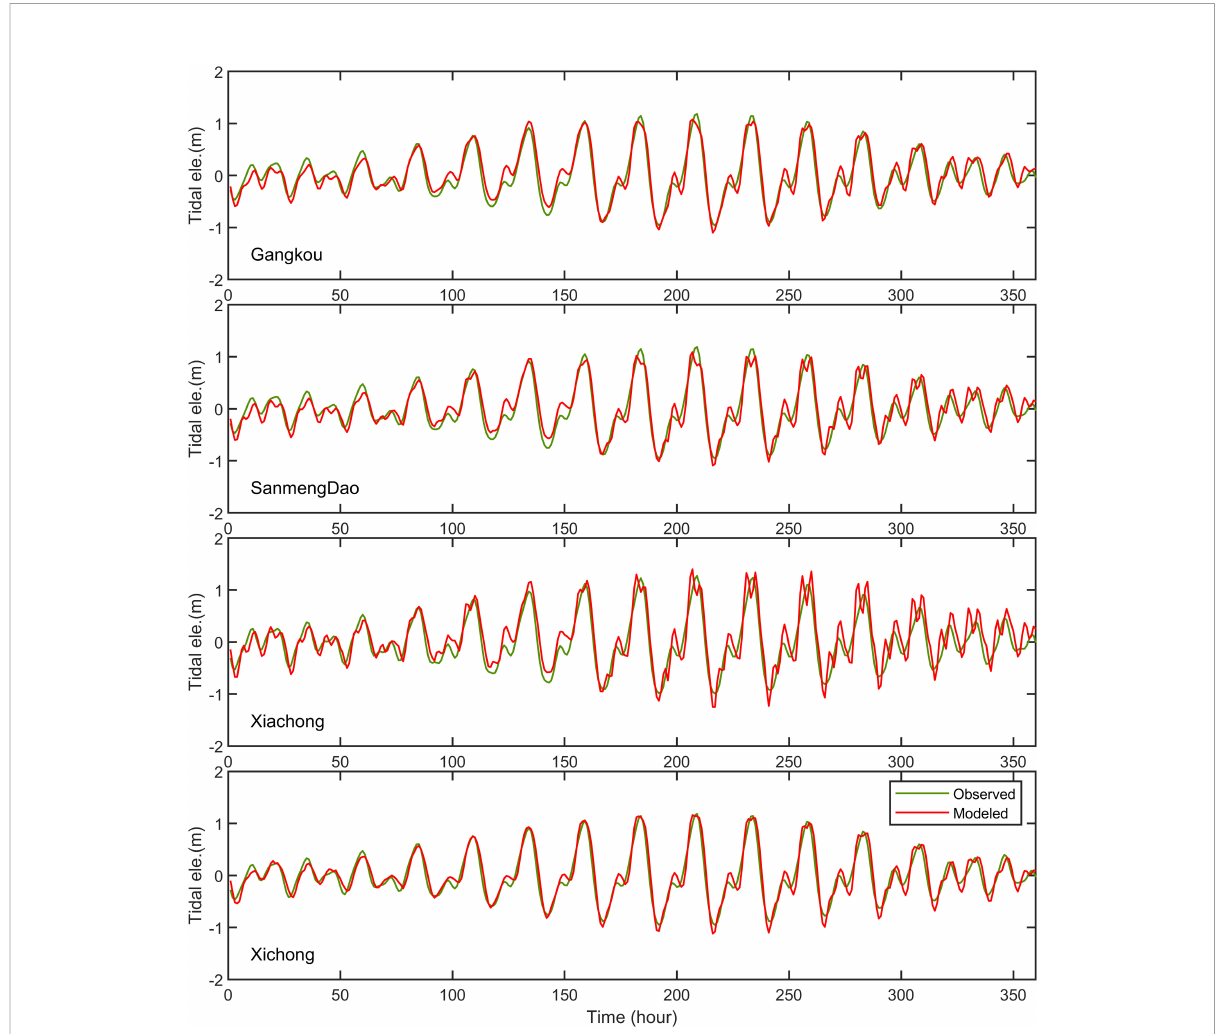
FIGURE 2 Comparisons of modeled hourly tidal level (red curves) with fi eld observations (green curves) at four stations (i.e., Gangkou, SanmenDao, Xiayong, and Xichong) with the positions shown in Figure